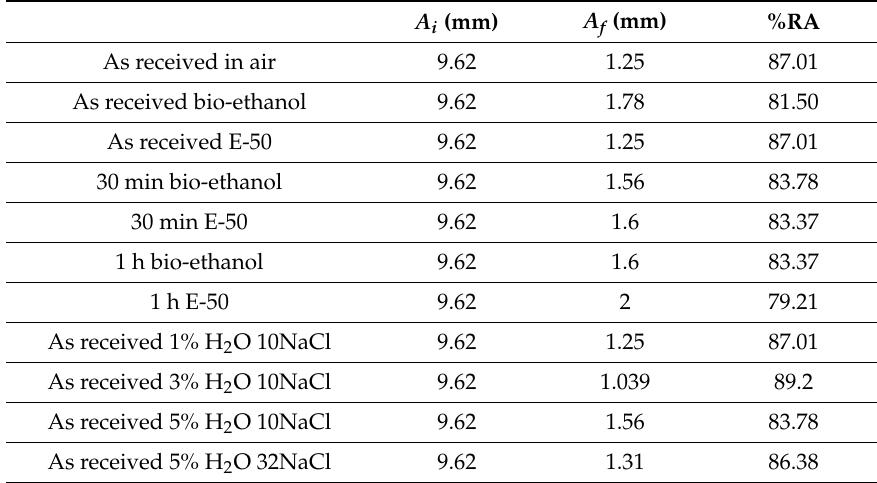
Figure 8. %RA corresponding to the SSRT. Table 7. SSRT test results.